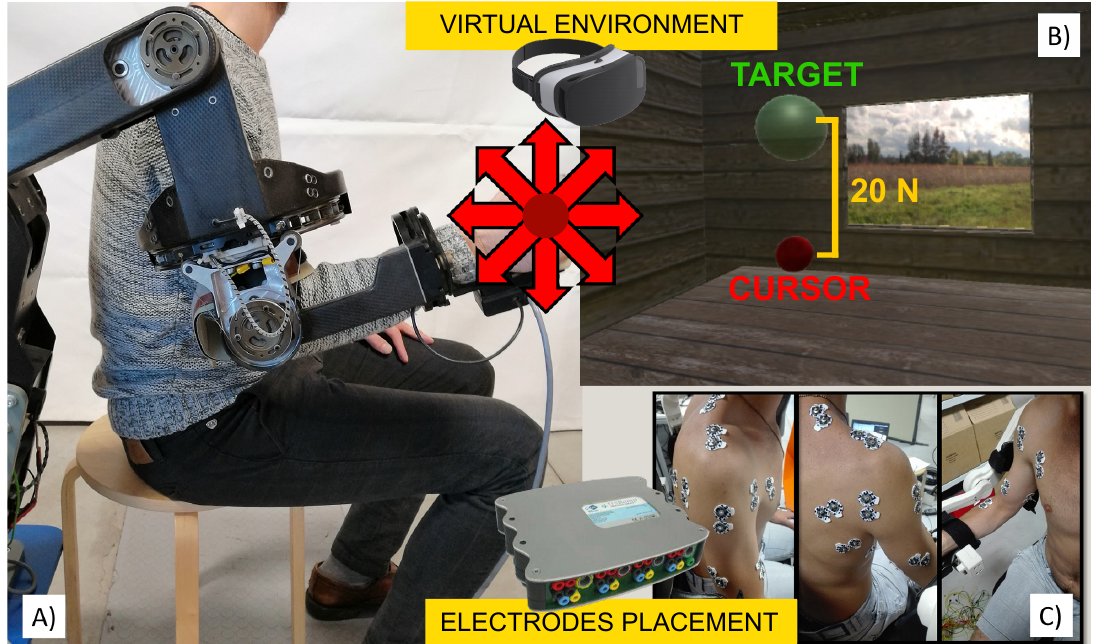
Figure 1. The experimental setup. ( A ) The subject that is wearing the upper limb L-Exos exoskeleton. ( B ) The virtual environment showing the cursor and the target sphere. ( C ) The surface EMG (sEMG) electrode